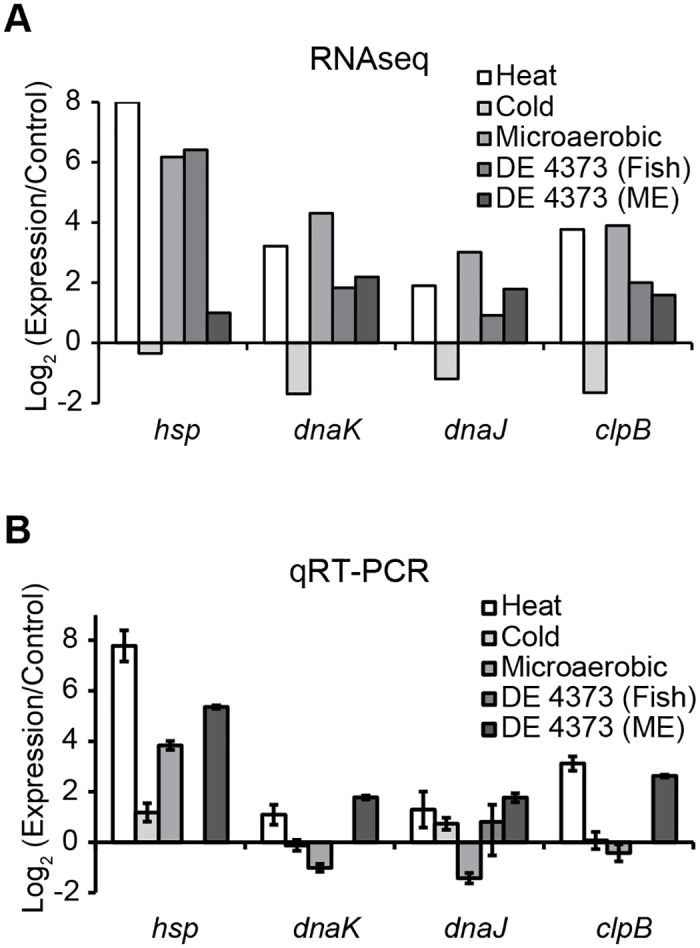
Change in the mRNA levels for selected heat shock induced genes.Change in the hsp, dnaK, dnaJ, and clpB mRNA levels: i) after exposure to heat, cold and microaerobic stress (in M. marinum CCUGrfp), ii) during infection of fish (M. marinum DE4373), and iii) in M. marinum DE4373 treated mosquito larvae (ME) relative to the levels in non-stressed (stress-free control) cells (see Materials and Methods for details). (A) Change in mRNA levels calculated from RNASeq data. The mRNA ratios are given as a generalized log2 fold (GFOLD) change of single replicates and plotted on a log2 scale such that positive values indicate higher mRNA levels after stress exposure, during infection, or in treated mosquito larvae. (B) Same as (A), but relative to the exponential pre-stress control. (C) Change in mRNA levels calculated from qRT-PCR data. Error bars indicate the variation within triplicate assays of one (Fish and ME; stress-free control) or two (heat, cold and microaerobic stress) biological replicates. In the fish, only dnaJ mRNA could be reliably detected by qRT-PCR.